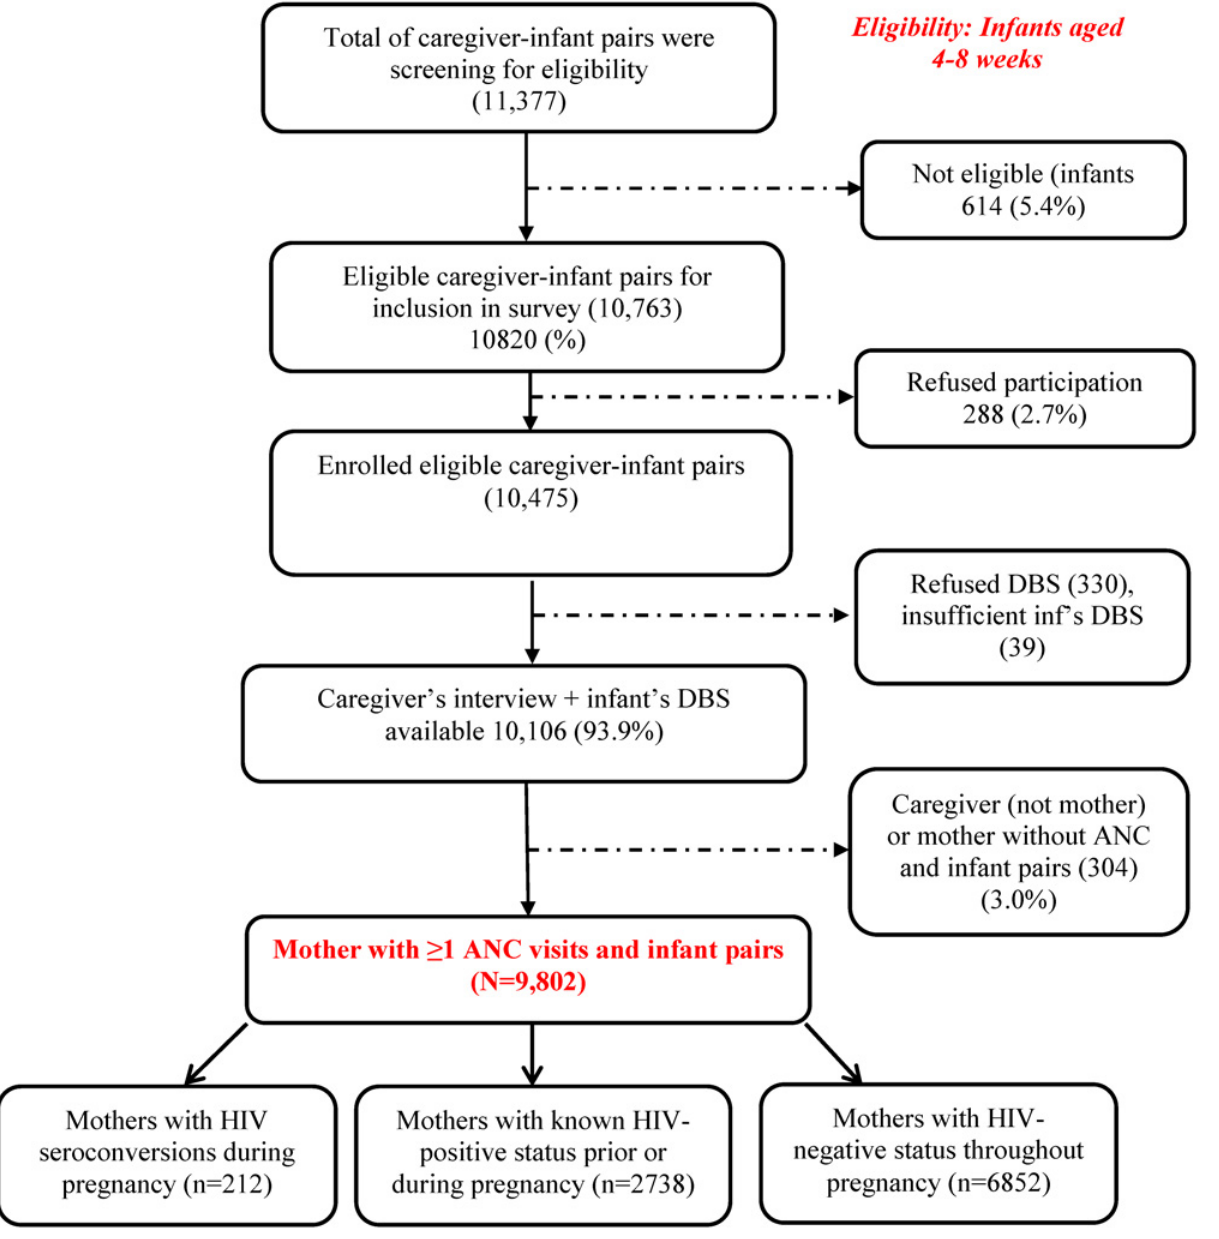
Fig 1. Profile of the evaluation of the effectiveness of the National Prevention of Mother-to-child transmission of HIV of the nested analysis of the maternal incident infection during pregnancy in South Africa, 2011 –